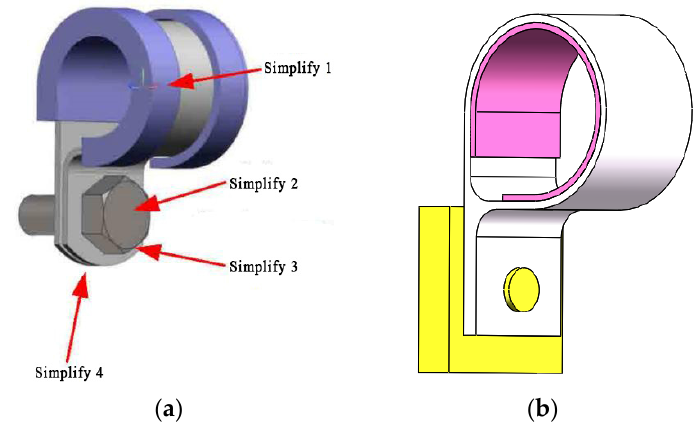
Figure 3. Simplified position and front-to-back comparison of the geometric model of the clamp. ( a ) Not simplified; ( b ) Simplified.